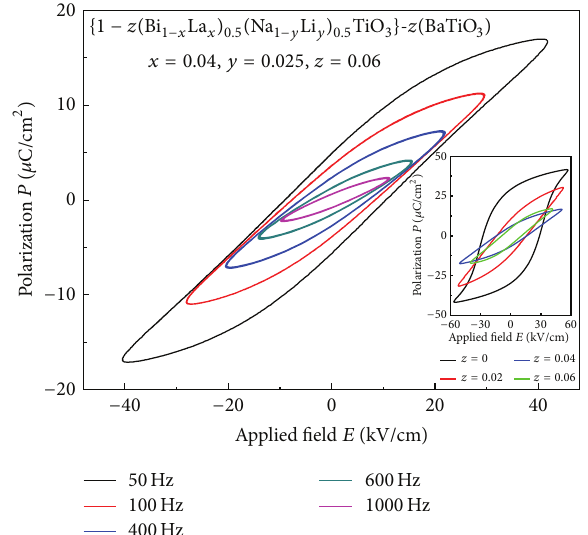
Figure 5: The P-E hysteresis loops of [ 1 − 𝑧 (BLNLT)- 𝑧 (BT), 𝑥/𝑦/𝑧 = 0.04/0.025/0.06] ceramics at